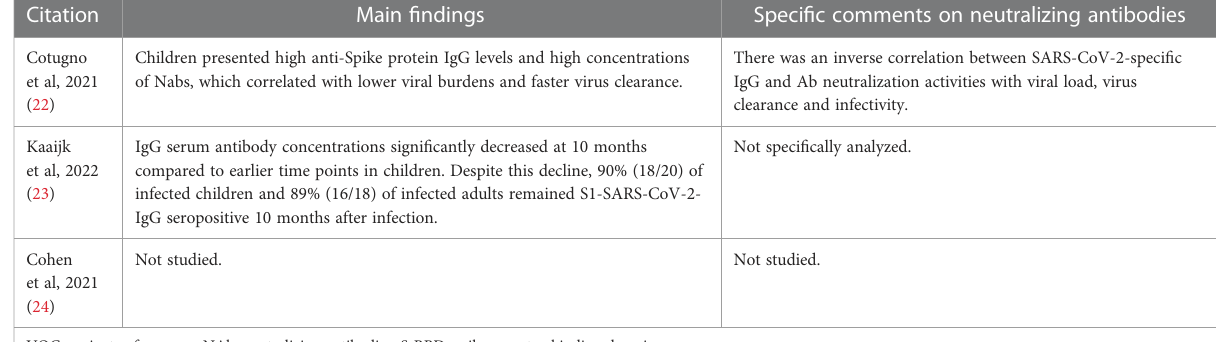
TABLE 3 Findings on T cellular immunity after infection.